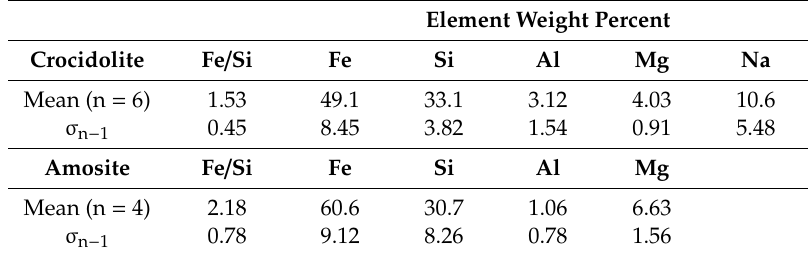
Table 2. Mean chemical composition and Fe / Si ratio, as determined by SEM-EDX, of non-coated fibres. Element Weight